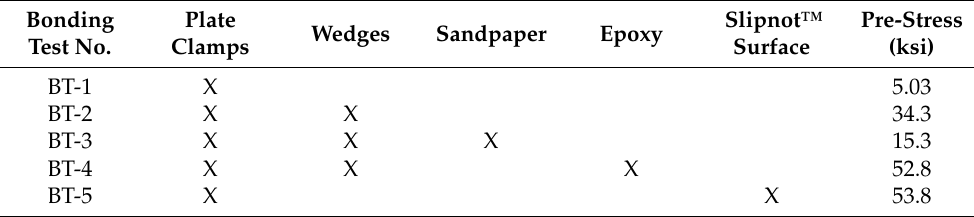
Table 5. Test variations to confirm the bond mechanism.